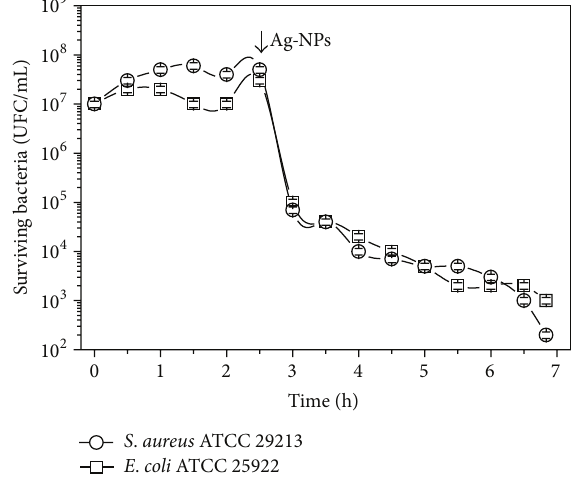
Figure 4: XRD spectrum of the biosynthesized Ag-NPs. Figure 5: Time-death curves for S. aureus ATCC 29213 (- I -) and E. coli ATCC 25922 (- ◻ -) using 0.6 pM Ag-NPs